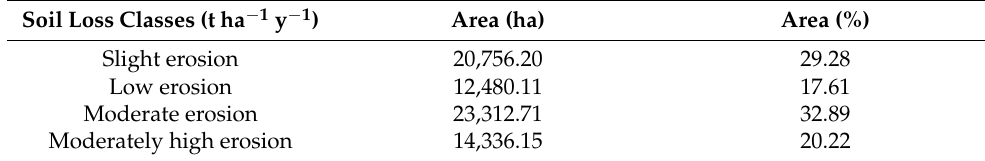
Table 4. Areas of soil loss over the study